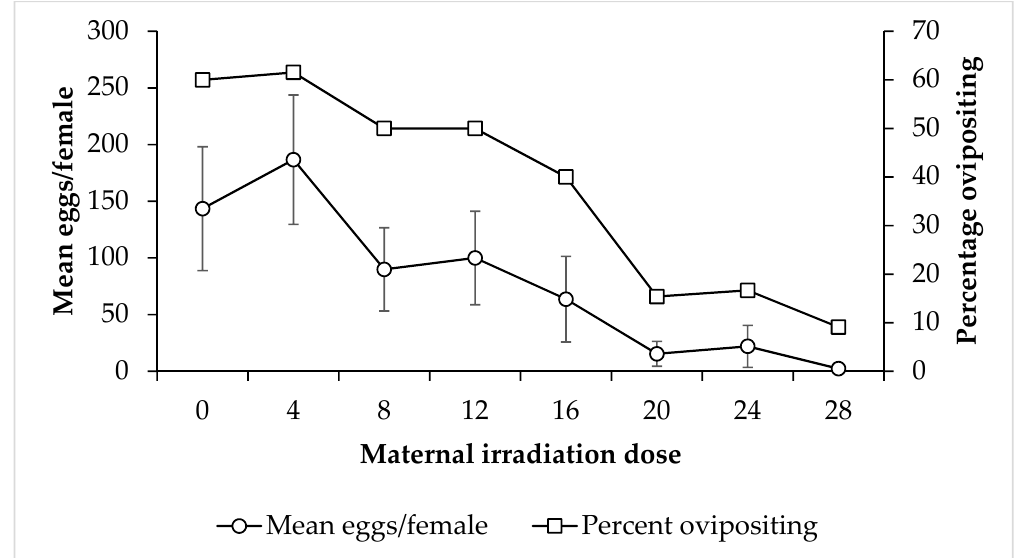
Figure 5. Mean number of eggs laid by irradiated female Nezara viridula after mating with untreated males (left axis), and the percentage of these females that laid eggs (right axis), separated by parental female irradiation dose. Error bars show standard error.